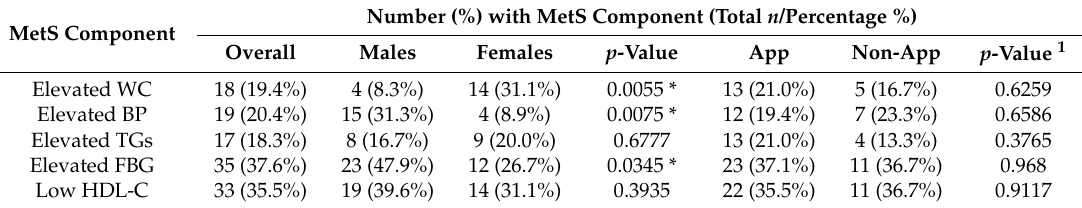
Table 5. Rates of individual metabolic syndrome